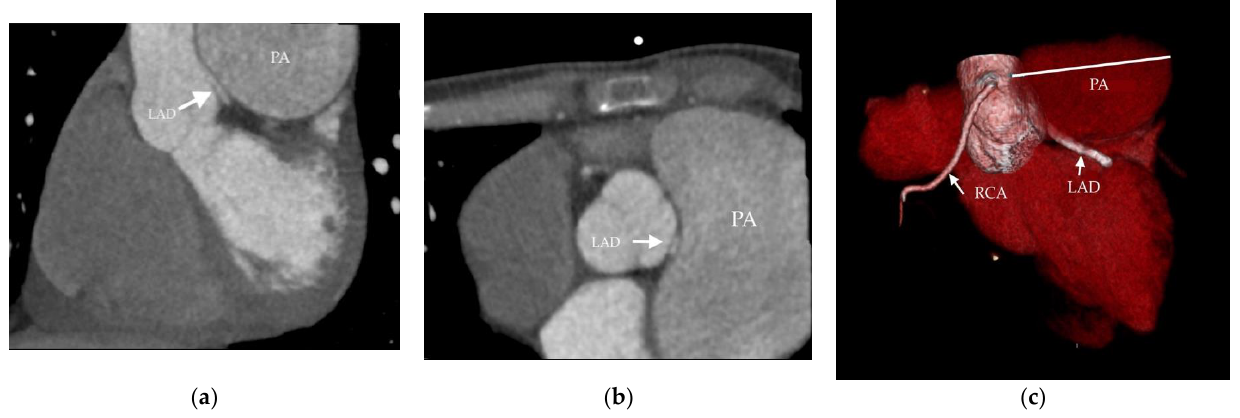
Figure 3. Coronary computed tomography angiography (Patient 1). The arrow shows the left as- cending artery (LAD) compressed by dilated pulmonary artery (PA): ( a ) sagittal view; ( b ) axial view; ( c ) 3D reconstruction. view; ( c ) 3D